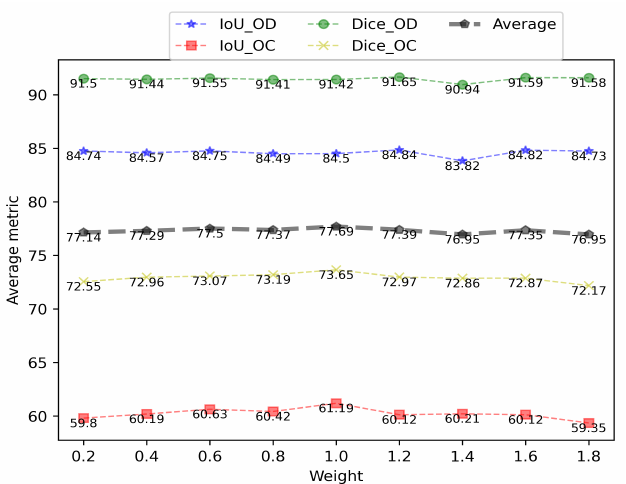
Figure 9. Illustration of trends in the values and means of the four indicators relative to the weights of the shape constraint